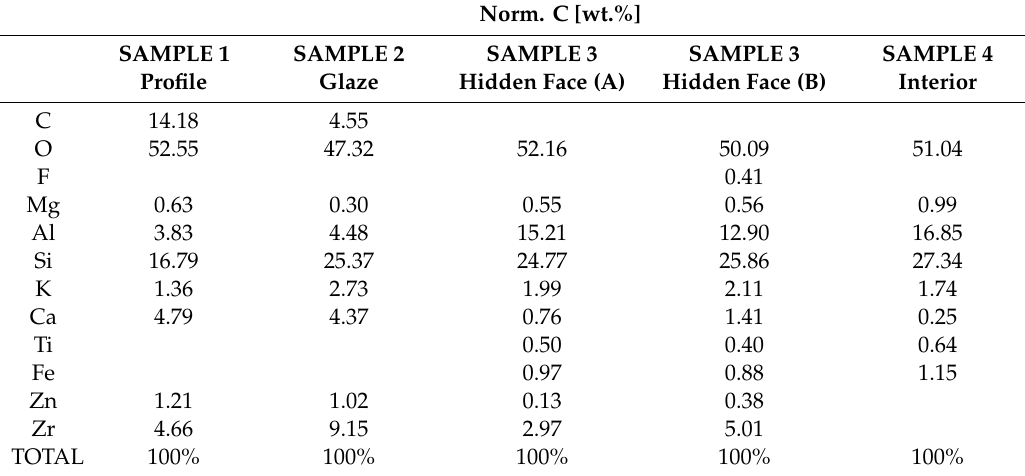
Figure 18. XRD of the ceramic tile’s hidden face. Presence of zirconium silicate Zr (SiO 4 ), silica (SiO 2 ) and tridymite (SiO 2 ). Table 1. Results of the presence of zirconium, zinc, titanium, iron, and aluminum in the 4 samples analyzed.